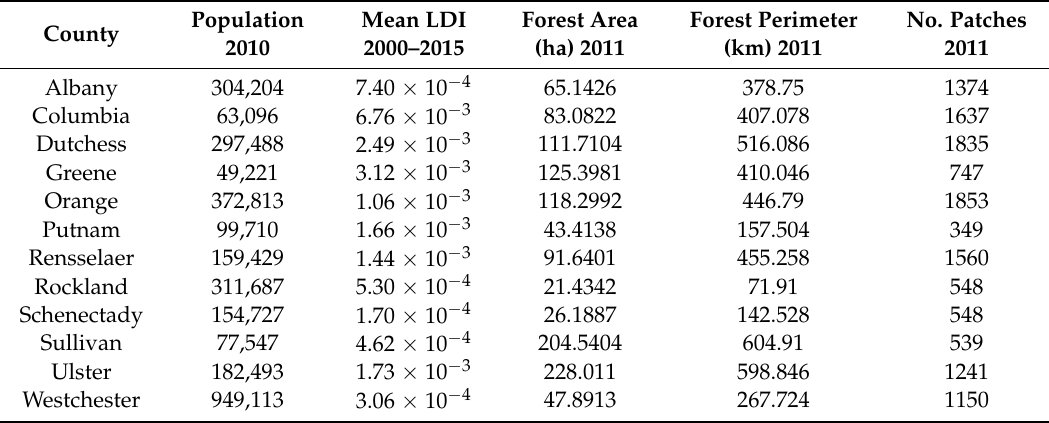
Table 1. County-level forest and LD statistics. Forest patch statistics only include deciduous and mixed forest patches with areas greater than 1 ha.